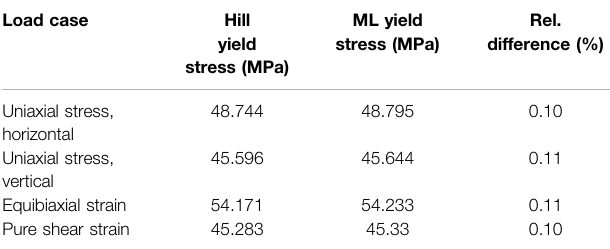
TABLE 4 | Yield stress obtained for a Hill-type reference material with analytical yield function and a material with an ML yield function trained to data from the reference material under four speci fi ed load